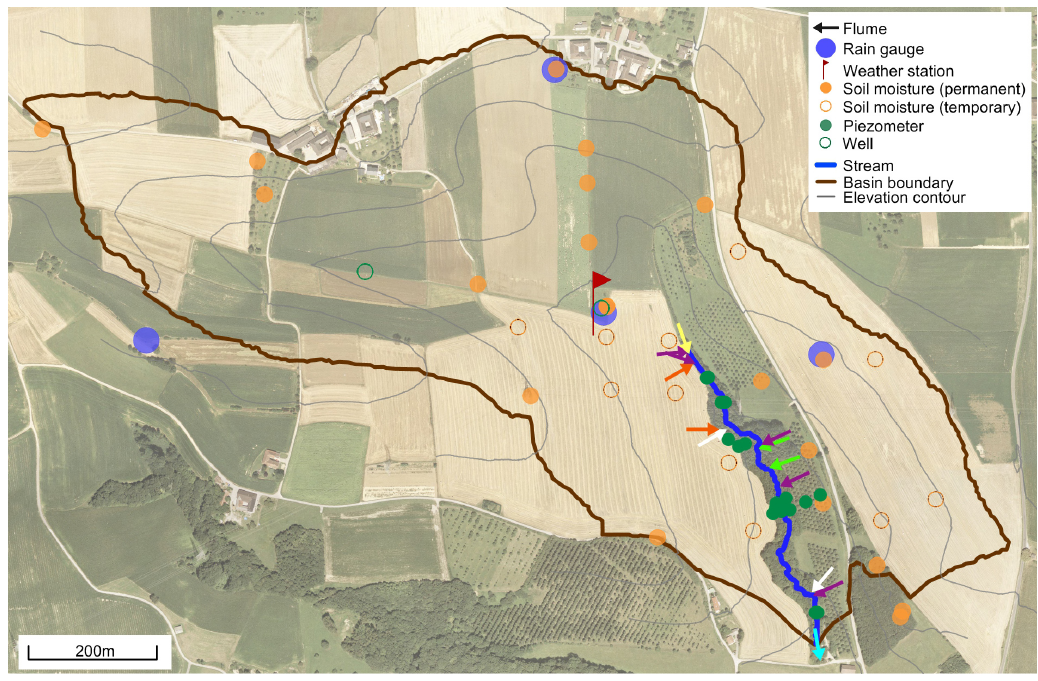
Figure 6. Instrumentation in the HOAL catchment (see Tables 1 and